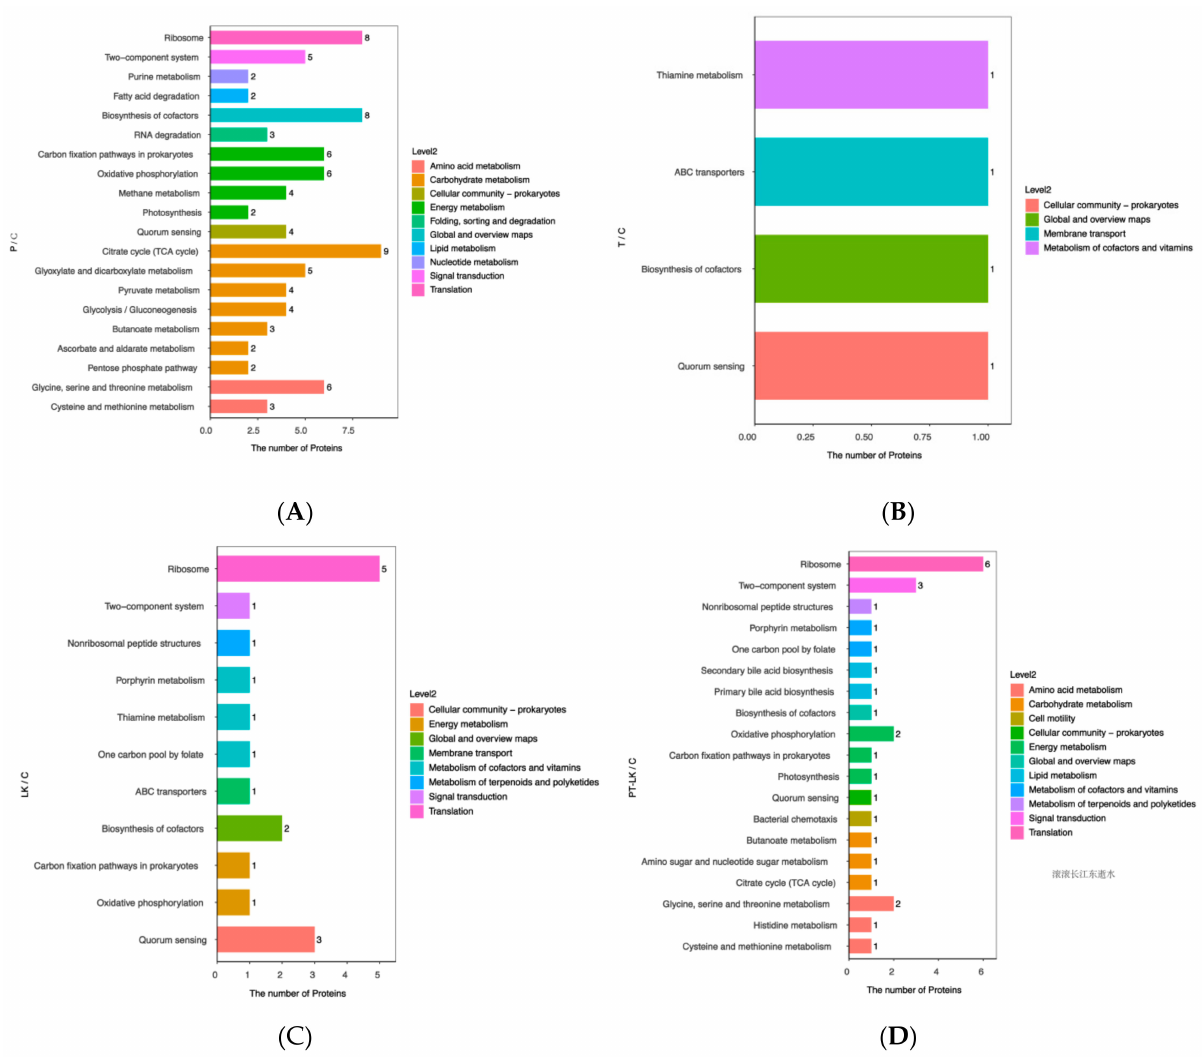
Figure 8. Distribution of DEPs in B. subtilis spores in KEGG level 2 in response to different treatments: ( A ) P/C, ( B ) T/C, ( C ) LK/C, and ( D )